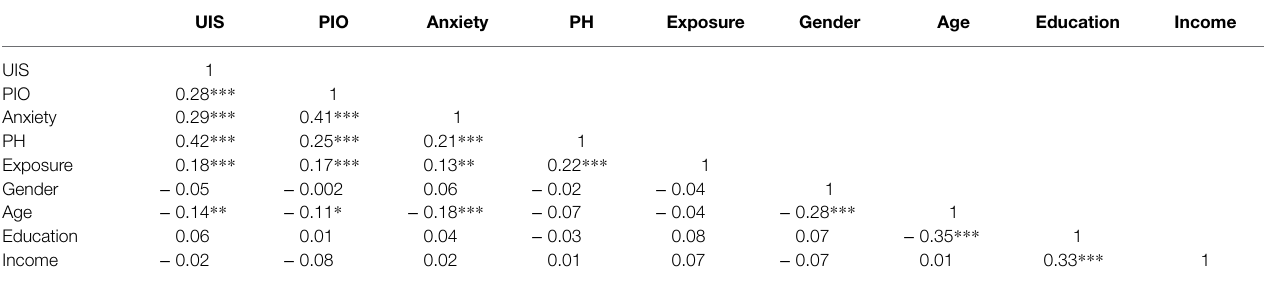
TABLE 2 | Correlations between the variables.